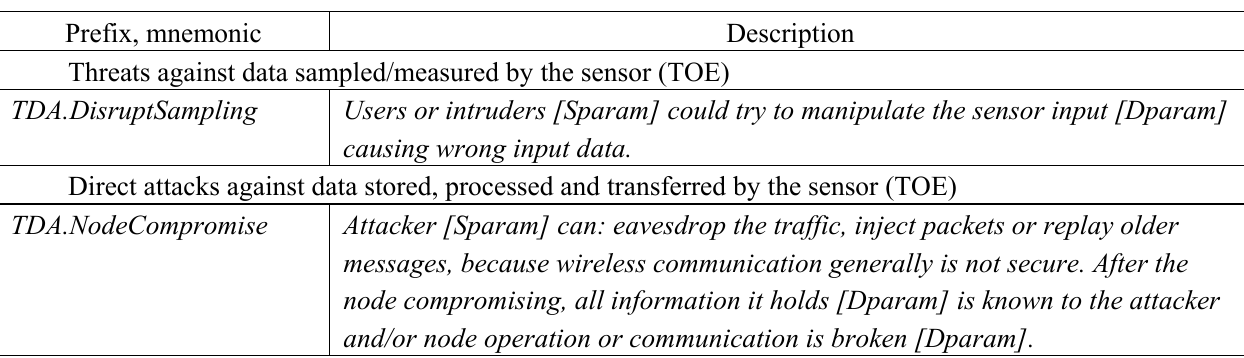
Table 10. Direct attacks against the intelligent sensor (TOE)—threats expressed by enhanced